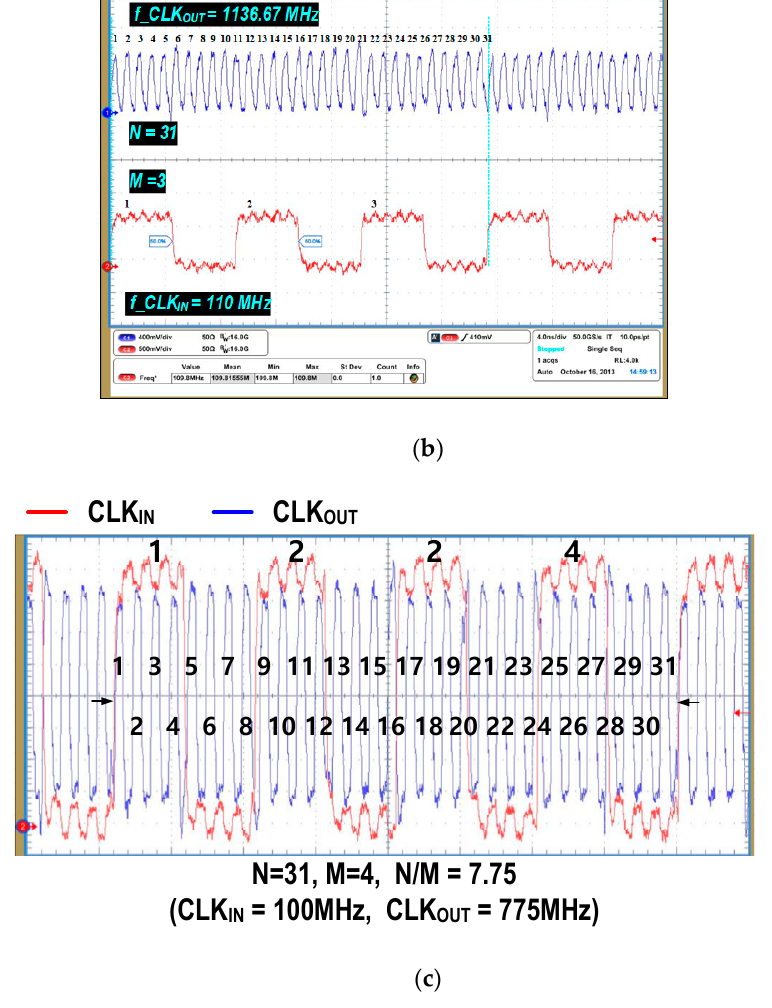
Figure 10. Measured input and output clock waveforms of the proposed N/M-ratio digital MDLL ( a ) f _CLK OUT = 700 MHz, f _CLK IN = 400 MHz, and N/M = 7/4; ( b ) f _CLK OUT = 1136.67 MHz, f _CLK IN = 110 MHz, and N/M = 31/3; and ( c ) f _CLK OUT = 775 MHz, f _CLK IN = 100 MHz, and N/M = 31/4.